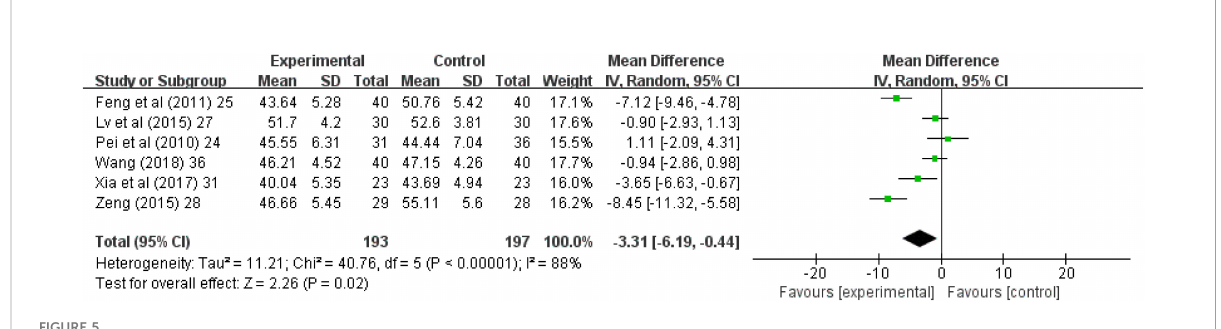
FIGURE 5 Forest chart of Self-rating depression scale. CI, Con fi dence Interval; IV, Information